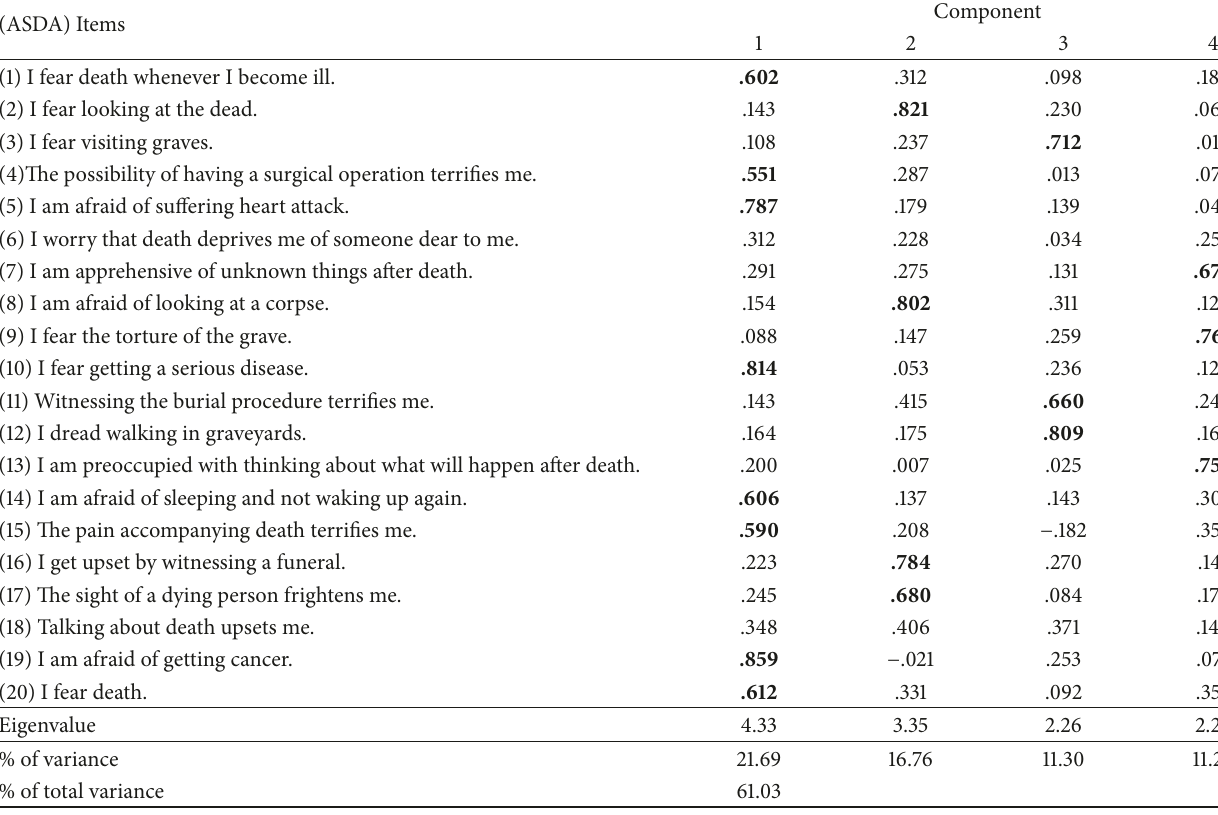
Table 1: Factor loadings of the Farsi version of the Arabic Scale of Death Anxiety (ASDA) in Iranian students ( 𝑁 = 252 ). (ASDA) Items